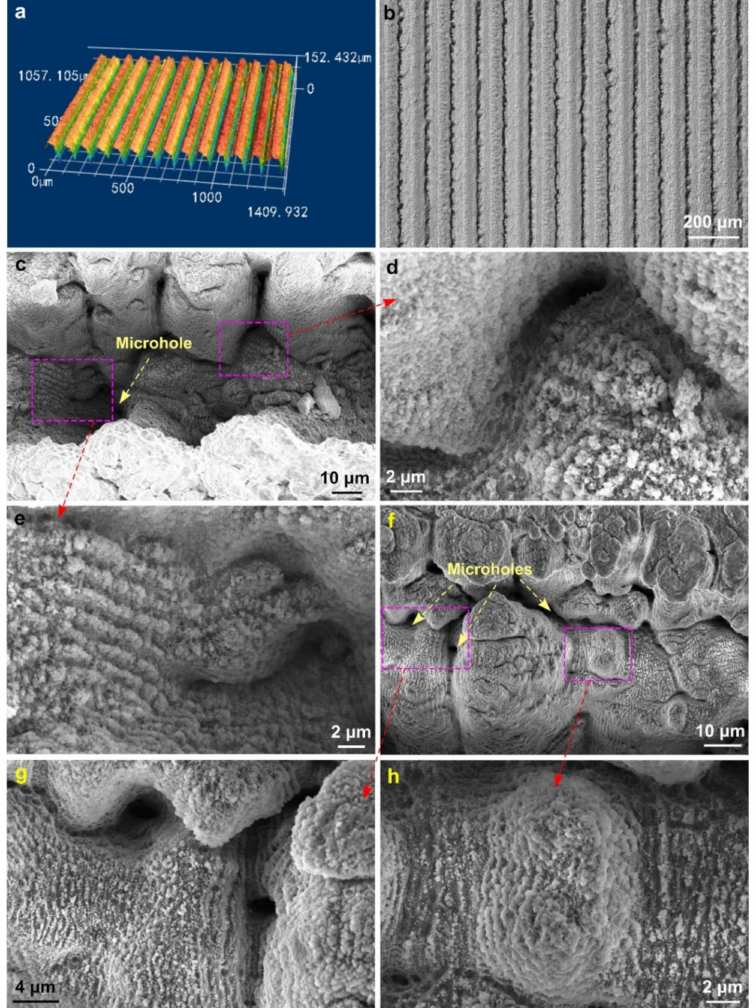
Figure 2. ( a ) Three-dimensional optical image of the array of parallel microgrooves. ( b ) Optical microscope image of the array of parallel microgrooves. ( c ) SEM image of a microgroove valley with areas textured by laser-induced periodic surface structures (LIPSS). ( d ) Magnified SEM image of LIPSS-textured area near microgroove wall. ( e ) Magnified SEM image of LIPSS-textured area in a microhole. ( f ) SEM image of a microgroove ridge with LIPSS-textured areas. ( g ) Magnified SEM image of LIPSS-textured area in ridge microholes. ( h ) Magnified SEM image of LIPSS-textured area around a ridge